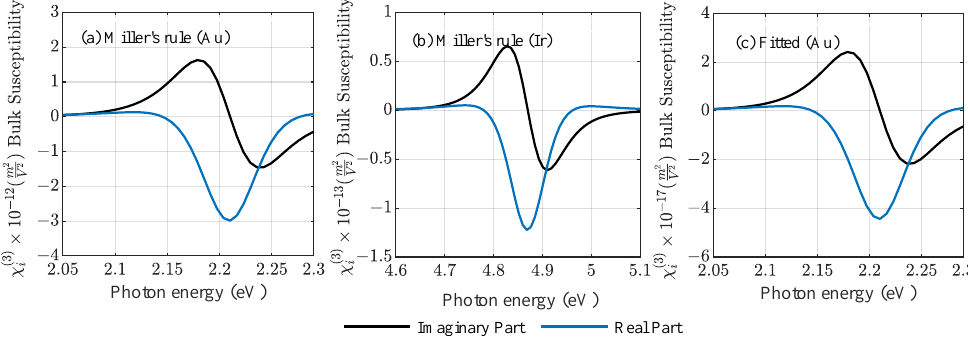
( 3 ) as a function of photon energy E = ¯ h ω for ( a ), ( c ) Au i